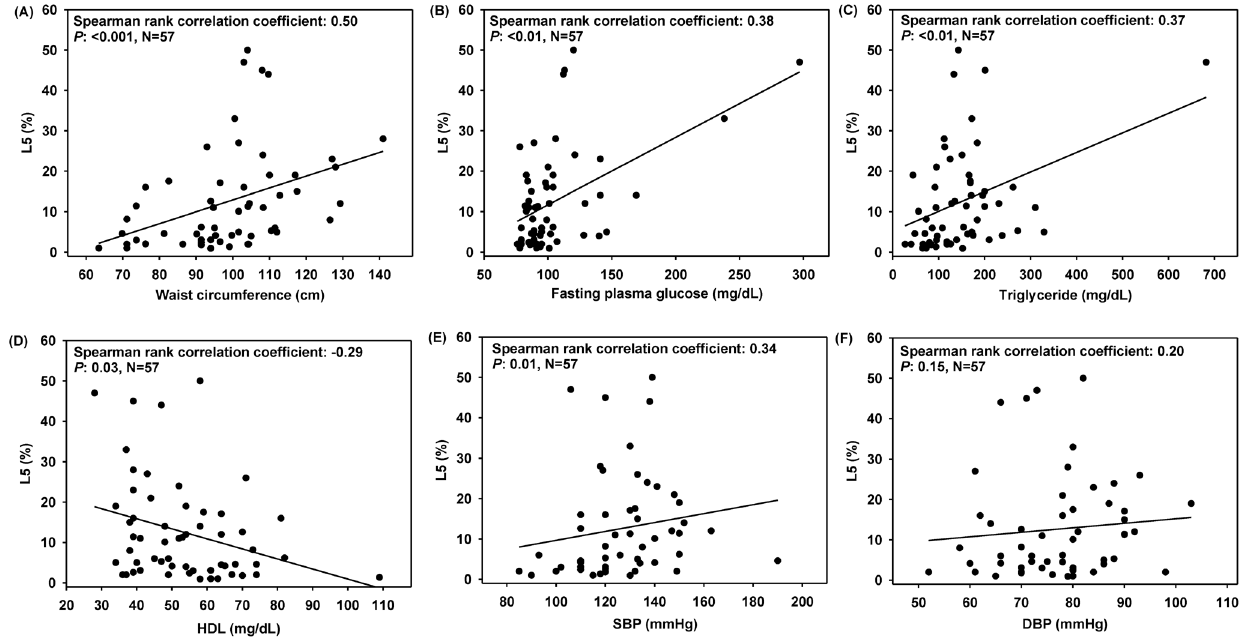
Figure 3. Correlation between L5 percentage (L5%) and various components of metabolic syndrome (MetS) criteria. L5% values were plotted against each component as indicated. Correlation between L5% and (A) waist circumference, (B) fasting plasma glucose, (C) triglyceride, (D)